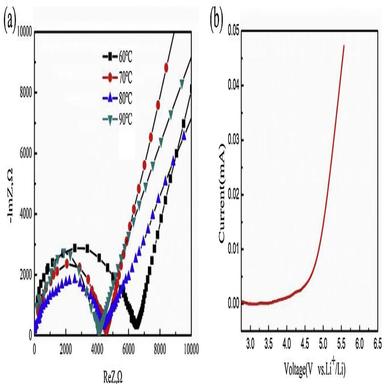
(a) The impedance spectra of LBF05@PEO electrolyte (PEO:F = 10) at 60–90 °C; (b) Liner sweep voltammogram for LBF05@PEO electrolyte (PEO:F = 10) at 70 °C.